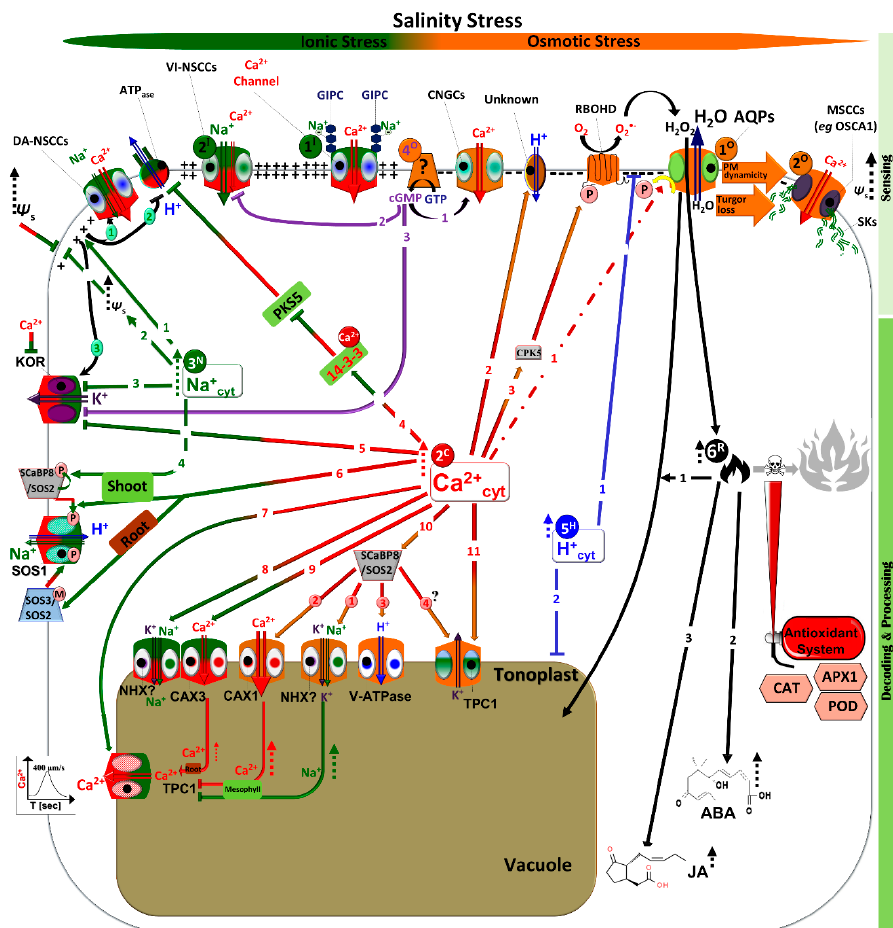
Figure 1. Molecular events and respective responsive cellular organelles/compartments under salt- and osmotic-related stress signaling. Half dark green-half red colored bars represent ionic-related stress and the orange color refers to osmotic stress as a common water-related stress component. Under different water-related stress types, fluxes of Na + , Ca 2+ , H + , and ROS take place with different spatiotemporal signatures, channeling plant cells to either adaptation or cell death. Details are given in the discussion. Green-colored arrows indicate specificity to ionic events (3 N ), while half green-half red colored arrows indicate Ca 2+ -activated signals (2 C ) that are related to ion stress. On the other hand, Ca 2 + -activated signals (2 C ) under osmotic stress are represented by red-orange colored arrows. Tow-line colored arrows indicate activation of ion fluxes on the plasma membrane and tonoplast by salinity / osmotic stress, where tow-line arrows colored with green, red, and blue represent Na + , Ca 2 + , H + , and K + flux, while tow-lines with dark blue colored arrows represent the H 2 O flux. Dashed arrows refer to a significant induction under stress. Green, red, blue, and black dashed arrows indicate activation of Ca 2 + , H + , and ROS signaling adaptation pathways, respectively, under water-related stress. Abbreviations: ROS: reactive oxygen species; Ψ s osmotic potential; KOR: K + outward rectifiers; NSCCs: nonselective cation channels; SOS: salt overly sensitive; NHX1: vacuolar Na + / H + exchanger 1; TPC1: two pore channel 1 ; GIPC: Glycosyl Inositol Phospho Ceramides; ABA: abscisic acid; JA: jasmonic acid; CAT: catalase; POD: peroxidase; GST: Glutathione S-transferase; AQPs: aquaporins; CAXs: Ca 2 +/ H + exchangers; VI-NSCCs: voltage-insensitive- NSCCs; DA-NSCCs: depolarization-activated-NSCCs; SCaBP8: SOS3-like calcium binding protein 8; PKS5: SOS2-like protein kinase; V-ATPases: V-type H + -ATPases; OSCAs: reduced hyperosmolality-induced [Ca 2 + ]i increase; MSCCs: mechanosensitive NSCCs; CNGCs: cyclic nucleotide gated NSCCs; cAMP: cyclic adenosine monophosphate; cGMP: cyclic guanosine monophosphate; RBOHD: respiratory burst oxidase homolog D; CPK5: calcium-dependent protein kinase